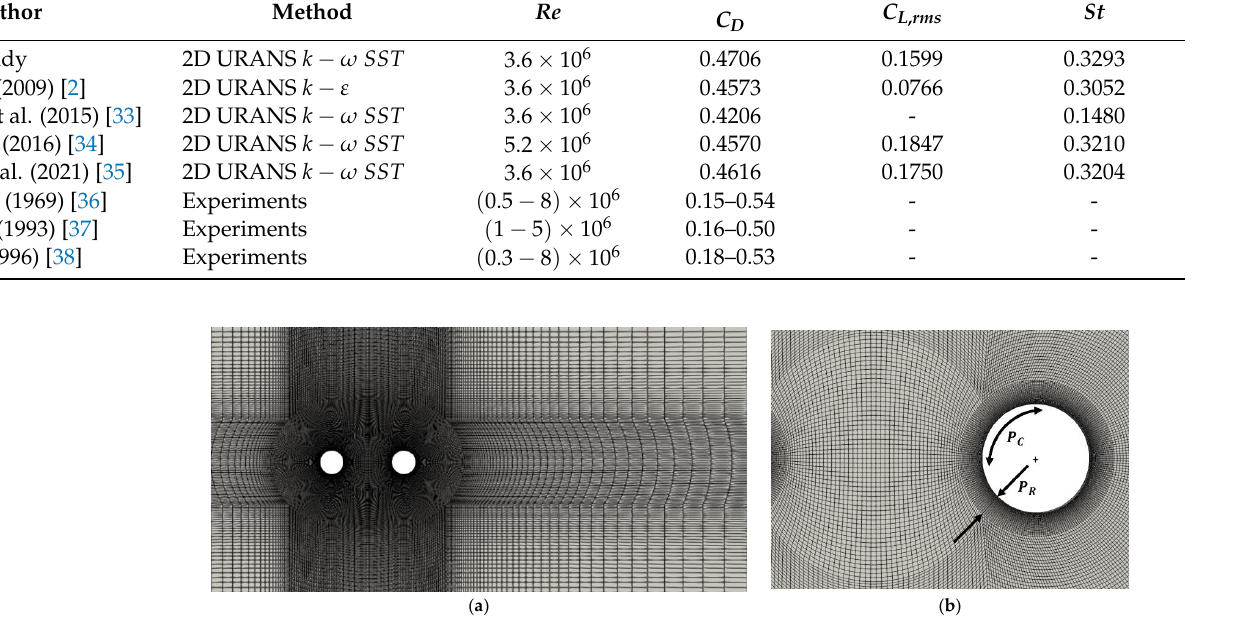
Figure 3. An example of the mesh for 𝐿/𝐷 = 3 ( a ) an overview of the mesh ( b ) a zoom-in view in the gap region. Table 2. Numerical and experimental data of a fixed single cylinder at high Reynolds number regime.